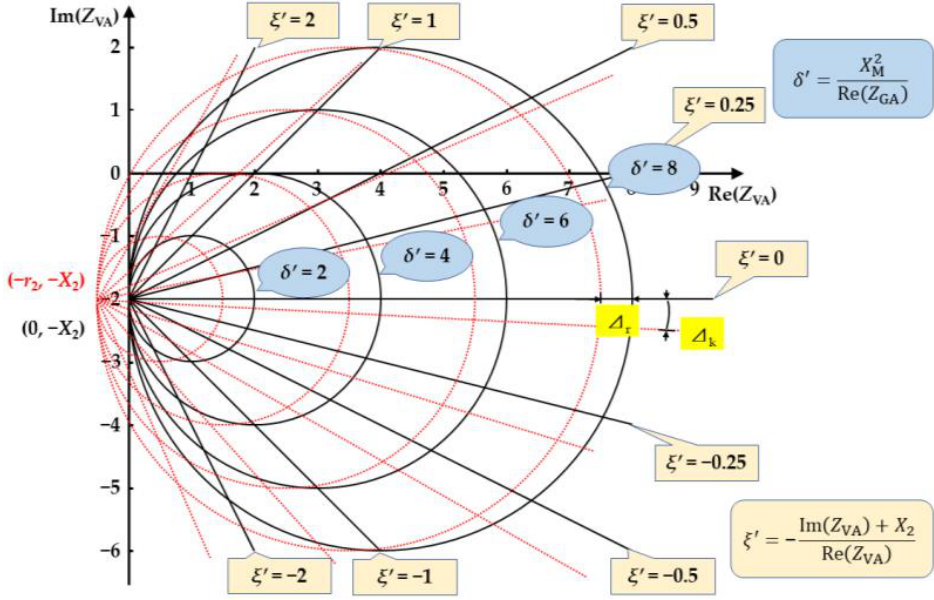
Figure 14. Reference region of inverter port impedance proposed by Tsinghua University.